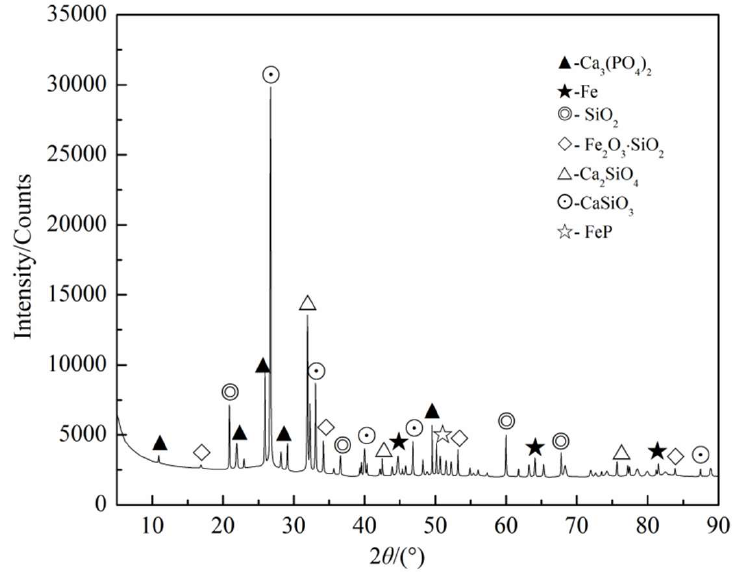
Figure 8. XRD analysis of the Ca 3 (PO 4 ) 2 –C–Fe 2 O 3 –SiO 2 system after coal-based